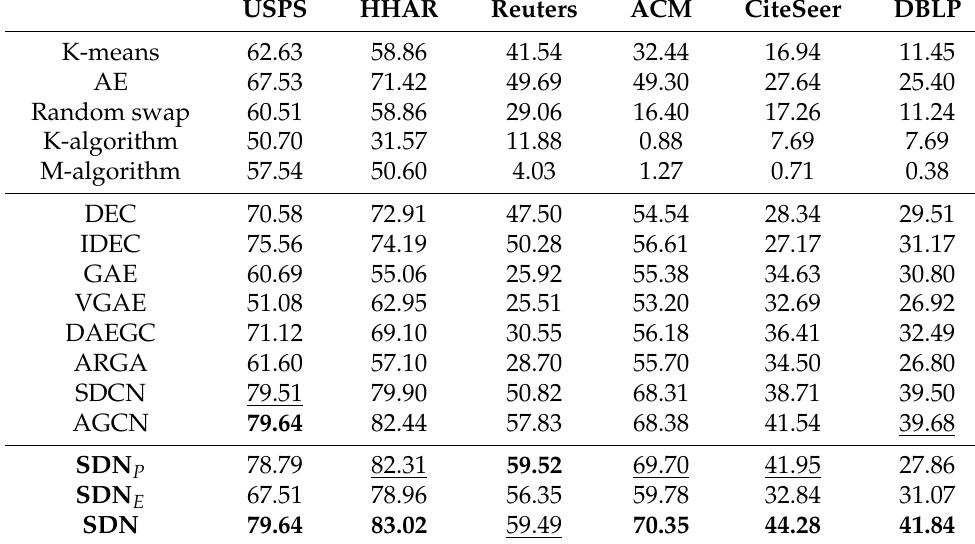
Table 6. Normalized Mutual Information (NMI) results on six